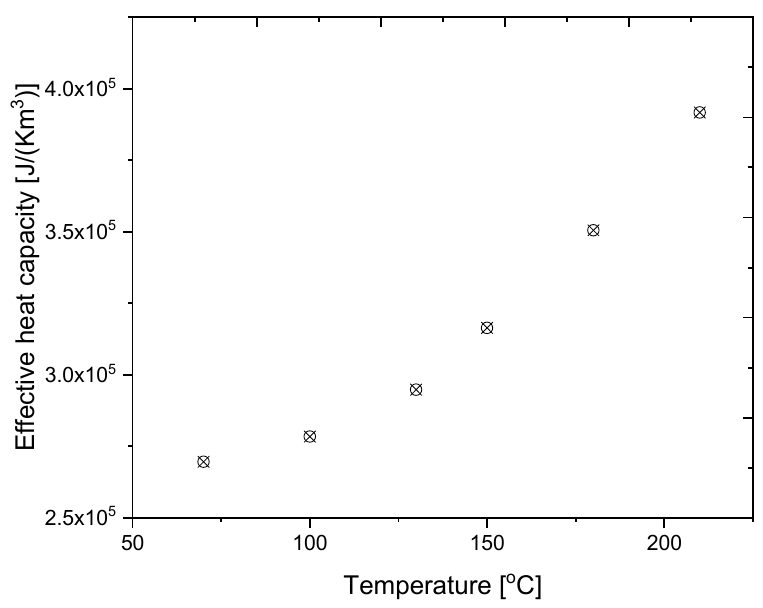
Figure 4. E ff ective heat capacity in the function of Figure 4. Effective heat capacity in the function of temperature .